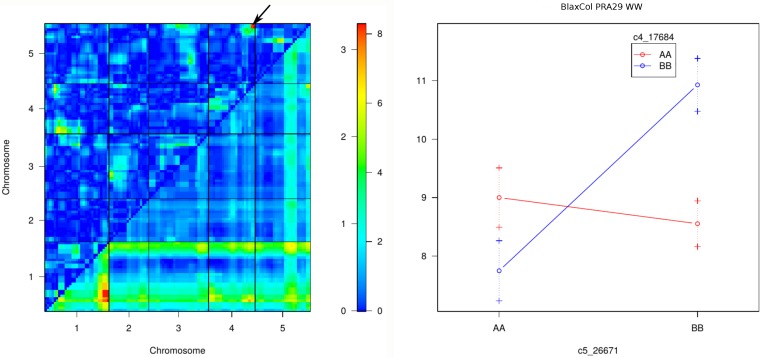
A significant epistatic interaction for PRA29 in BlaxCol.A significant epistatic effect on PRA29 between the bottom of chromosomes 4 and 5 segregating in the BlaxCol RIL set. Results shown in WW condition. Left panel: heatmaps representing the LOD score of the full model with additive and interaction effects (triangle below diagonal; 0–8 LOD scale) and that of the interaction effects only (triangle above diagonal; 0–3 LOD scale) for PRA29 in BlaxCol and WW condition. The LOD scales for significance are indicated on the right of the heatmaps. An arrow indicates the most significant interaction, which phenotypic consequences are detailed on the right panel: the interaction plot represents the average RIL phenotype (PRA29 in cm2; +/-1 SE) for each allelic combination ('AA' = homozygous Col; 'BB' = homozygous Bla) at the 2 closest markers.